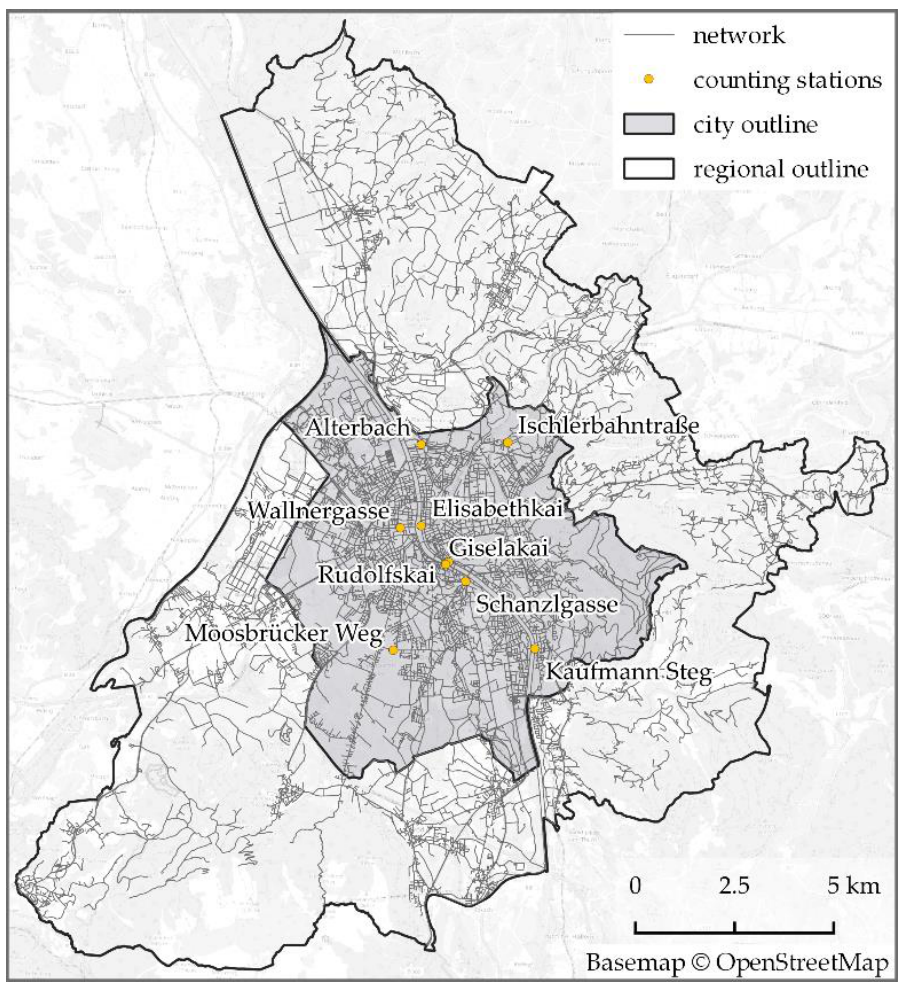
Figure 1. The study area of the greater region of Salzburg city with the transportation network and counting stations.